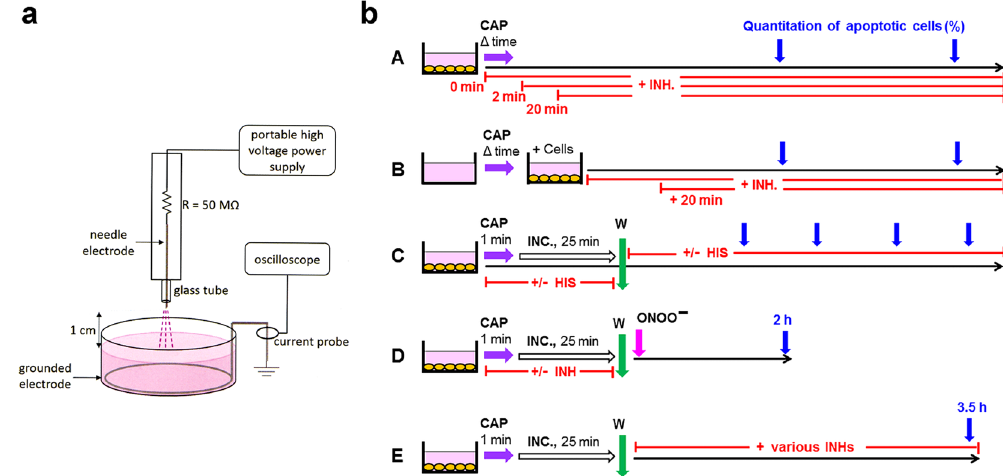
Figure 1. The plasma source and the experimental procedures used in this study. ( a ) Schematic drawing of the portable plasma source used in this study. The portable plasma source enabled operation in the corona and transient spark regime, as described under Methods 69–71 . ( b ) Experimental procedures. A. Tumor cells were treated with CAP for varying times, combined with the addition of specific inhibitors/scavengers (INH) at defined time points. Apoptosis induction was quantified at different times. B. The same princples as shown under A were applied, except that medium was treated with CAP in the absence of cells, and was then transferred to the cells. C. Tumor cells were treated with CAP for 1 min, followed by 25 min incubation in the same medium. After a washing step, incubation was continued in fresh medium. The 1 O 2 scavenger histidine was present either before or after the washing step. Apoptosis induction was determined kinetically. D. Tumor cells were treated with CAP (or PAM) in the absence or presence of defined inhibitors/scavenger and incubated for 25 minutes in the same medium. After a washing step, the degree of inactivation of membrane-associated catalase was determined through a ONOO − challenge and determination of ONOO − mediated apoptosis induction 12 . E. Tumor cells were treated with CAP for 1 min and incubated in the same medium for 25 min. After a washing step, further cultivation of the cells was performed in the absence or presence of defined inhibitors/scavengers (INHs) that allowed to define the molecular species involved in apoptosis-inducing signaling after catalase